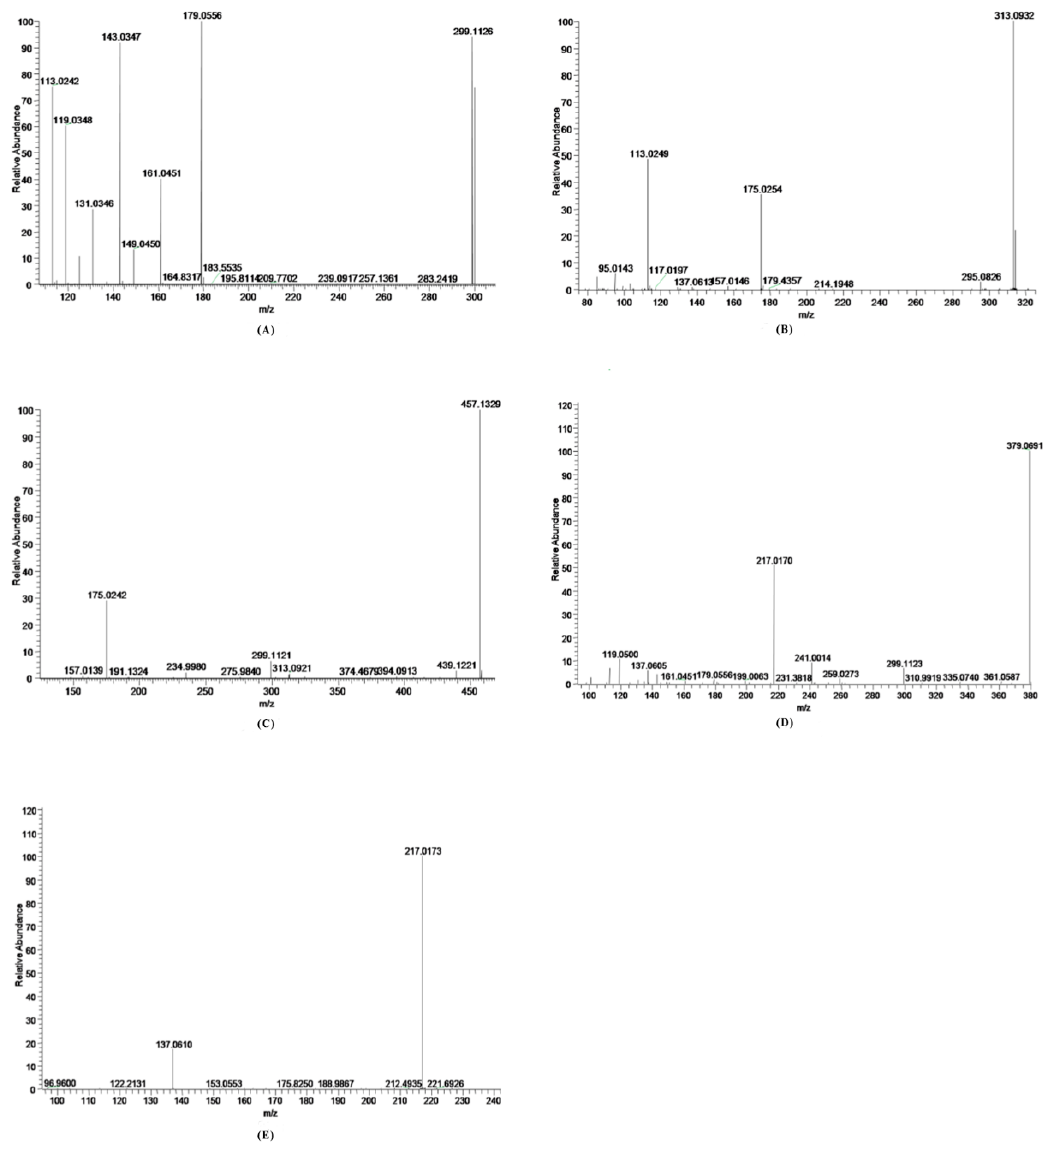
Figure 2. Representative MS/MS spectrum: ( A ) M0 ( m / z 299); ( B ) M1 ( m / z 313); ( C ) M2 ( m / z 475); ( D ) M3 ( m / z 379); ( E ) M4 ( m / z 217).